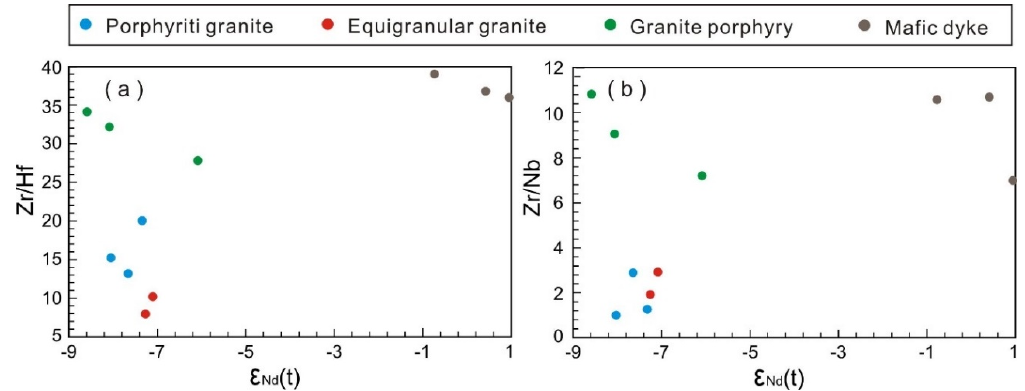
Figure 12. Plots of ( a ) Zr/Hf vs. ε Nd(t) and ( b ) Zr/Nb vs. ε Nd(t) showing the magmatic Plots of ( a ) Zr / Hf vs. ε Nd(t) and ( b ) Zr / Nb vs. ε Nd(t) showing the magmatic differentiation model. di ff erentiation